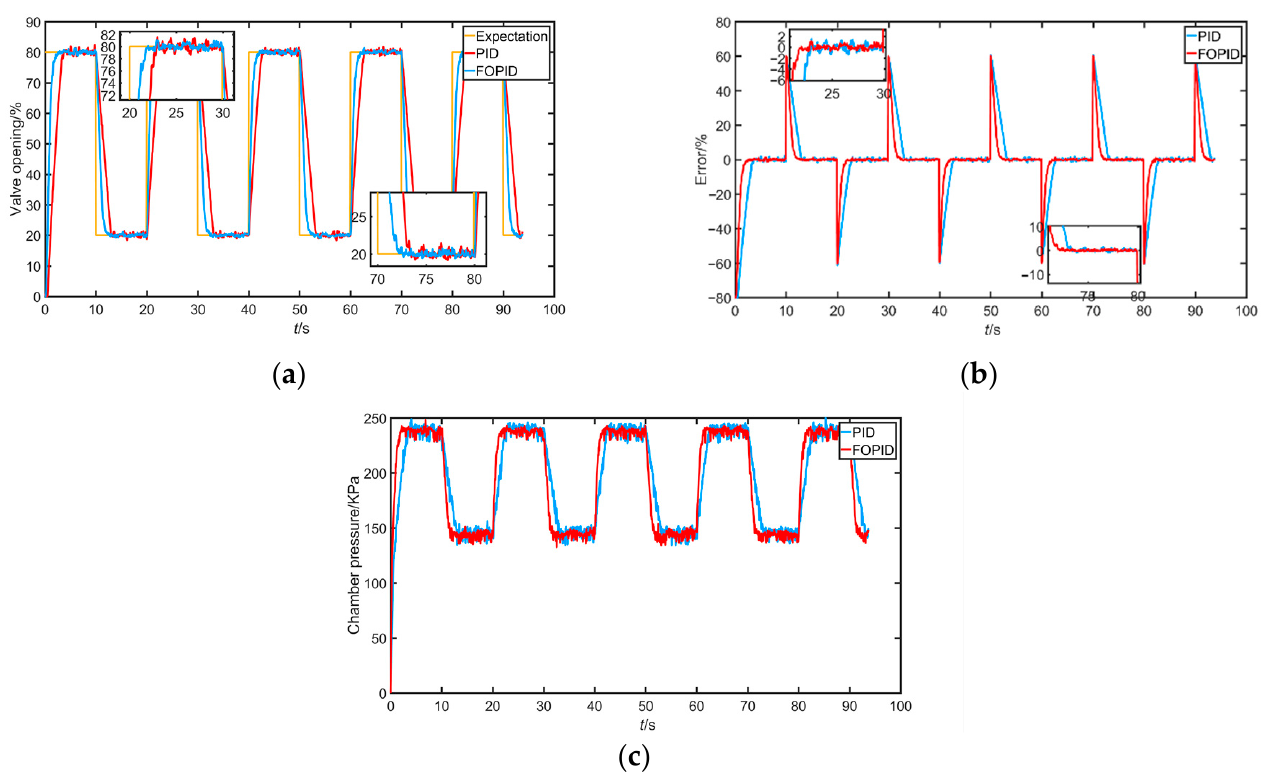
Figure 20. ( a ) Response signal under square wave tracking; ( b ) error of response signal under square wave tracking; ( c ) corresponding air chamber pressure under square wave tracking.